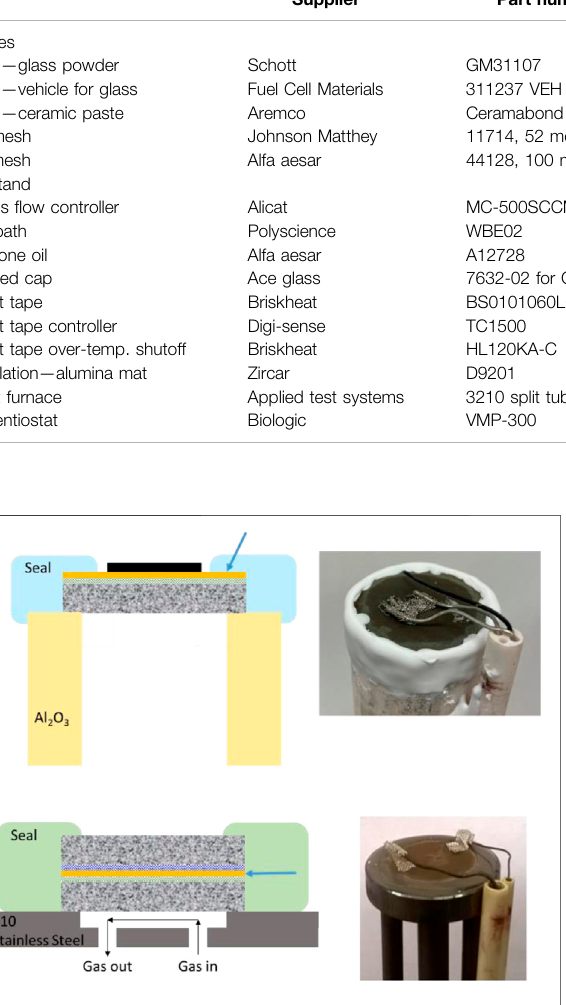
FIGURE2| SchematicandphotographsofMS-SOECssealedontotest rigs. Electrical lead wires and gas tubing are omitted from the schematic for clarity. The arrows point to the critical sealing surface where the seal material (lightblueorlightgreen)contactsthedenseelectrolytelayer(orange). (A) MS-SOEC with a metal support on one side only, and exposed electrolyte on the perimeter of the top surface, sealed to an alumina tube test rig using ceramic adhesive. (B) Symmetric-architecture MS-SOEC mounted with glass seal on a test rig machined from 410 stainless steel. Note that the sealing surface is much smaller for (B)